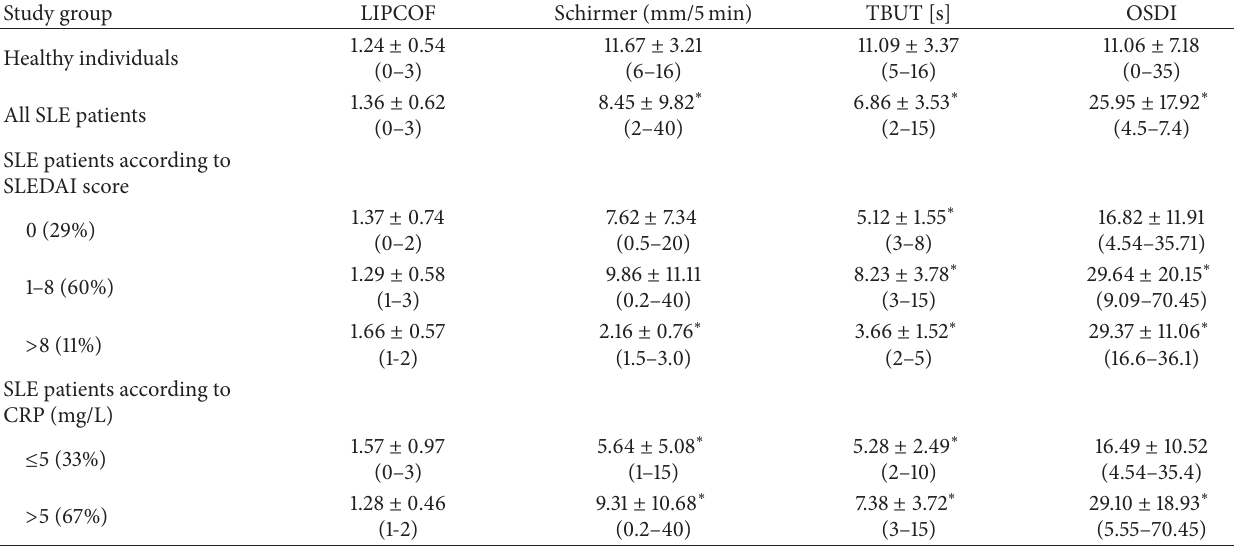
Table 1: Dry eye related parameters in different subgroups of SLE